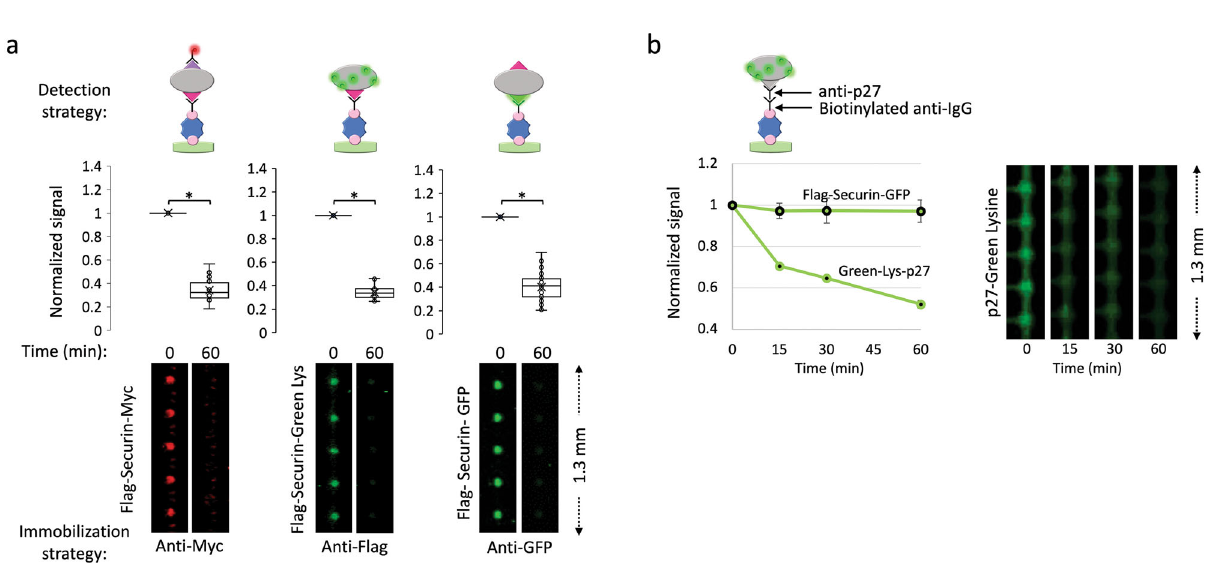
Fig. 2 On-chip analysis of protein degradation assays. a Time-dependent degradation of 35 S-labeled Flag-Securin-GFP, Flag-Geminin-GFP and their non- degradable variants ( Δ 64 and Δ 27, respectively) in NDB mitotic extracts (20 µ l) supplemented with E-mix and Ubiquitin. Time-dependent proteolysis was resolved by SDS-PAGE and autoradiography. b Equivalent assays were performed with non-radioactive IVT products. Target proteins were incubated 1 h in reaction solution containing either extracts or PBS (control). Aliquots of each reaction mix (5 µ l) were then loaded directly on a chip via separate channels, each containing dozens of cell units. Target proteins were immobilized to protein chambers via biotinylated anti-GFP antibody. The GFP tag was also used for quanti fi cation. GFP signals were calculated from 14 – 19 cell units per target protein per reaction condition (extracts vs. PBS). Box plots depict ratios of GFP signals (extracts/PBS) at t 60 min . Mean (x) and median (-) are indicated. * p value < 0.001. Representative raw data depicting detection on chip of the four target proteins are shown. c The degradation of Flag-Securin-GFP variant was assayed in tube as described in B. Here, however, aliquots were snap- frozen every 15 min. Time-lapse samples were then loaded on the chip for analysis. Target proteins were immobilized in protein chambers via anti-GFP antibodies and quanti fi ed based on GFP fl uorescence. Time-dependent degradations of w.t vs. mutant Securin were quanti fi ed based on 35 S signal (standard analysis; n = 3] and GFP fl uorescence (on-chip analysis). Plots depict mean signals and standard error bars. Mean signals were calculated from 26 cell units and normalized between max (1, t 0 ) and min ( 0 , t 60 min ) values, allowing proper comparison between two very different methods of detection. Error bars are shown. d Equivalent experiment to (c) performed with Flag-Geminin-GFP, except that immobilization was based on anti-Flag antibodies. n = 30 – 40 cell units.